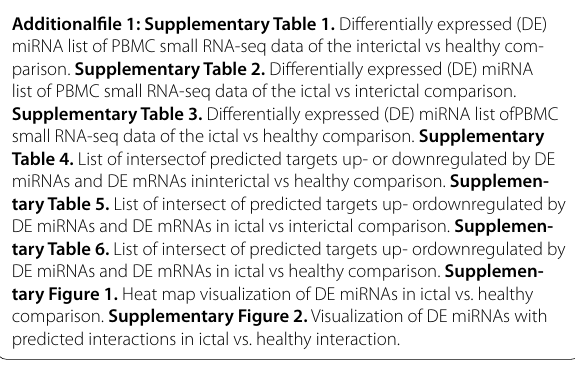
Table 4. List of intersectof predicted targets up- or downregulated by DE miRNAs and DE mRNAs ininterictal vs healthy comparison. Supplemen‑ tary Table 5. List of intersect of predicted targets up- ordownregulated by DE miRNAs and DE mRNAs in ictal vs interictal comparison. Supplemen‑ tary Table 6. List of intersect of predicted targets up- ordownregulated by DE miRNAs and DE mRNAs in ictal vs healthy comparison. Supplemen‑ tary Figure 1. Heat map visualization of DE miRNAs in ictal vs. healthy comparison. Supplementary Figure 2. Visualization of DE miRNAs with predicted interactions in ictal vs. healthy interaction.